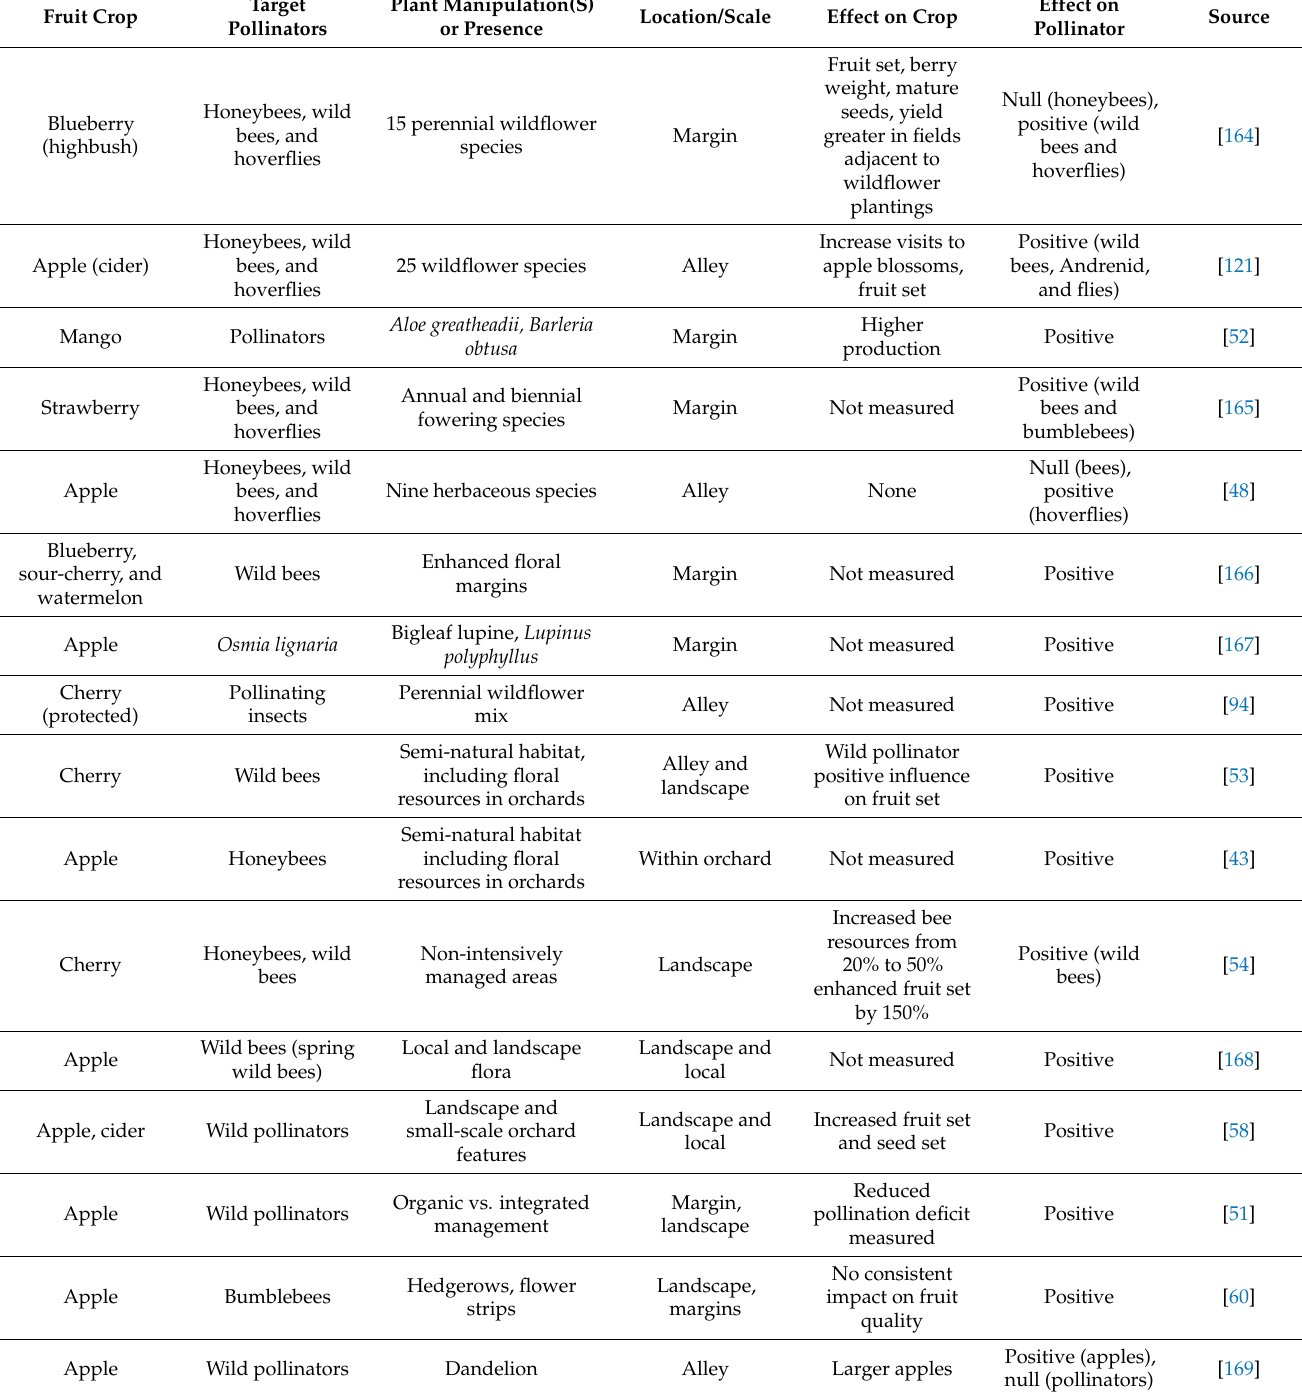
Table 3. Effects of wildflowers or cover crop floral enhancements on insect pollinators and fruit production. The effect of plant manipulation on pollinator numbers and/or diversity is positive, null, or negative. NB: different effects may be due to species growth, location, or